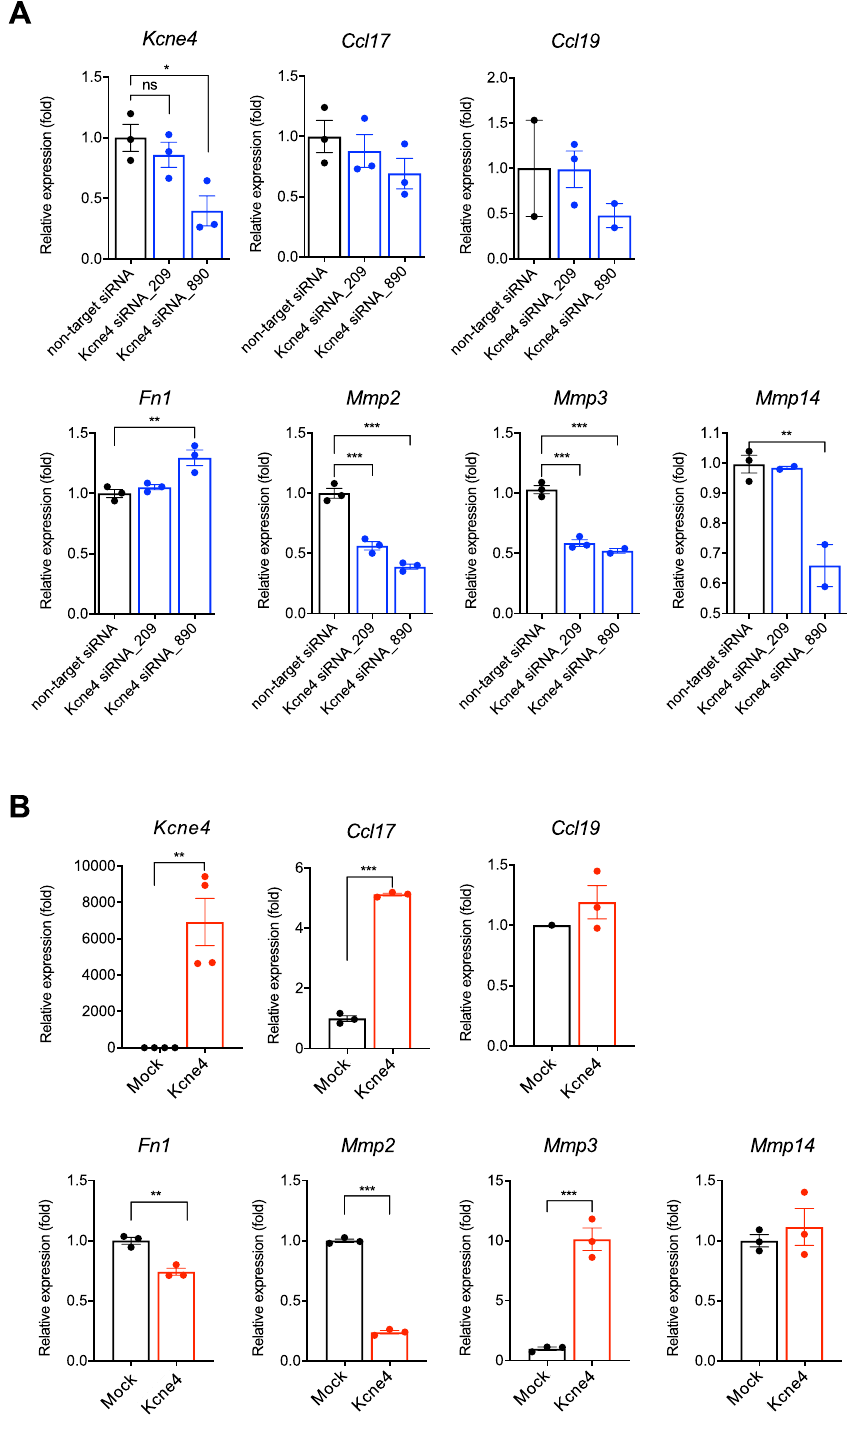
Figure 5. Effects of KCNE4 on the expression of chemokines and adhesion factors in primary cultured LECs. ( A ) Kcne4 was suppressed by siRNA, and expression levels of Ccl17, Ccl19, Fn1, Mmp2, Mmp3 , and Mmp14 were analyzed by qRT-PCR. ( B ) LECs were transfected with KCNE4 expression plasmid, and expression levels of Ccl17, Ccl19, Fn1, Mmp2, Mmp3 , and Mmp14 were analyzed by qRT-PCR. One-way ANOVA, * p < 0.05, ** p < 0.01, *** p < 0.001; Student’s t test, * p < 0.05, ** p < 0.01, *** p < 0.001. ns; not